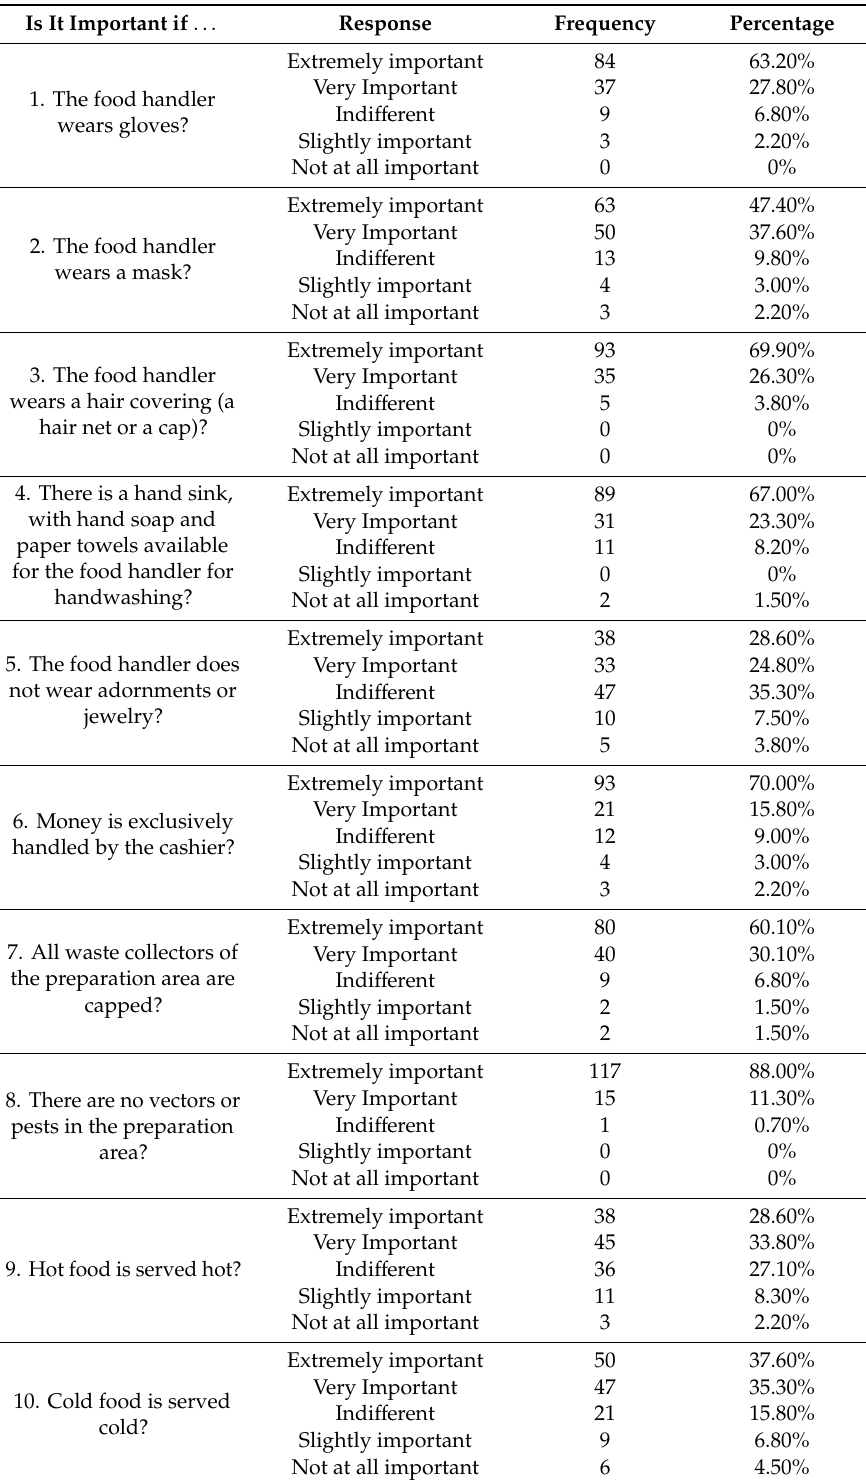
Table 3. Food safety importance perception of food truck consumers studied in the Federal District, Brazil ( n = 133). Is It Important if